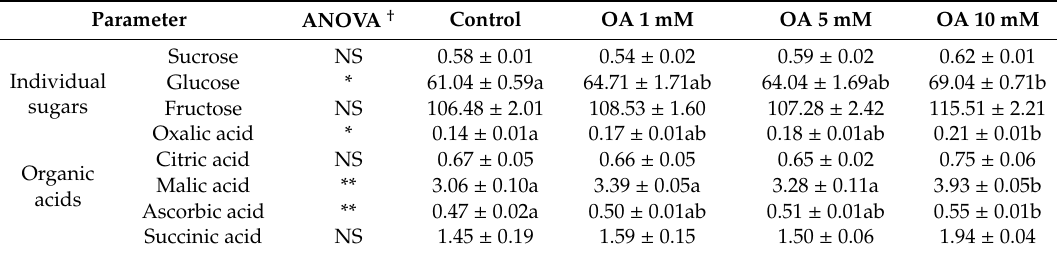
Table 2. E ff ects of preharvest oxalic acid (OA) treatments (1, 5, and 10 mM) on individual sugar and organic acid concentration (g kg − 1 ) in the first picking date in 2016 experiment. Data are the mean ± SE.